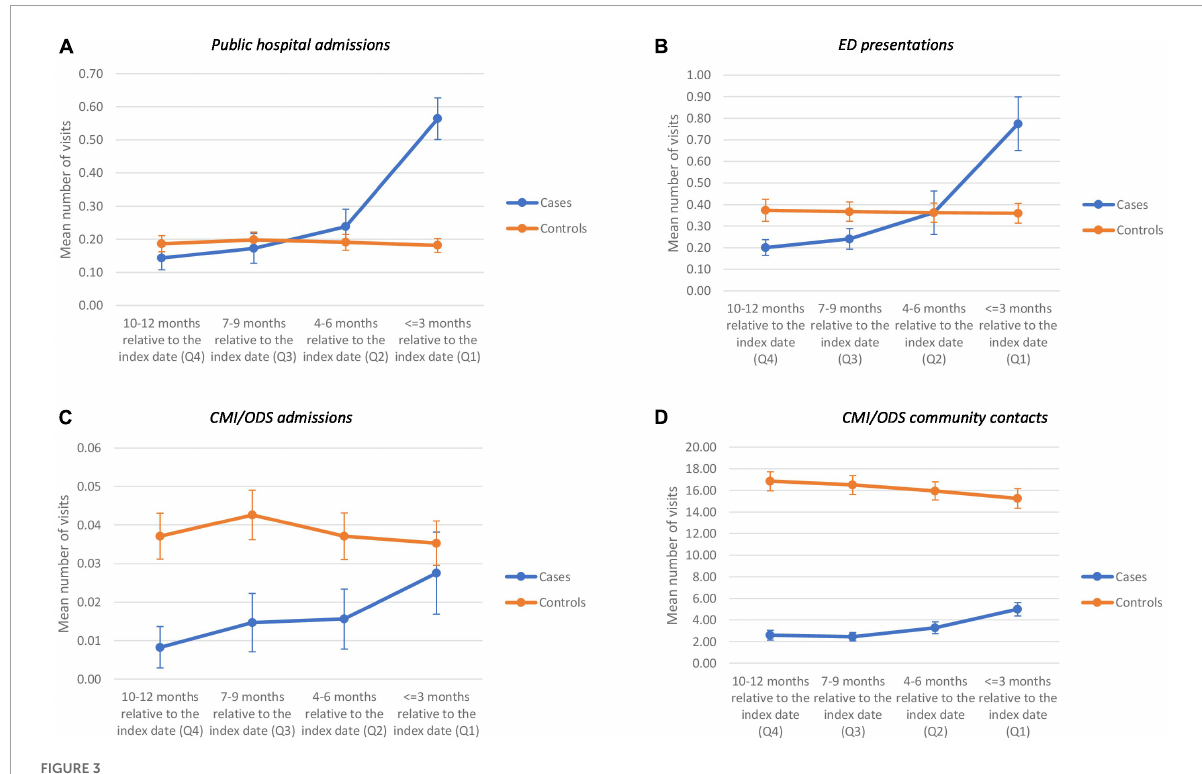
FIGURE3 Mean number of visits by quarter in the 12 months prior to suicide for cases and controls by service type (A–D)